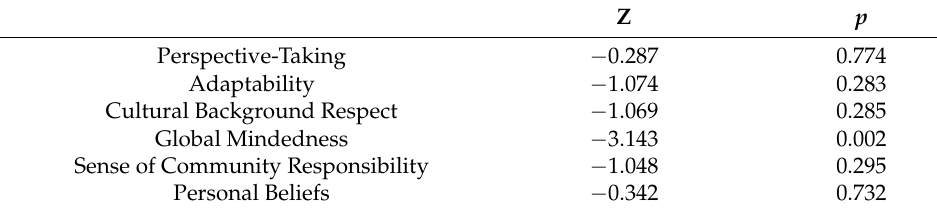
Table 2. Wilcoxon signed-rank test